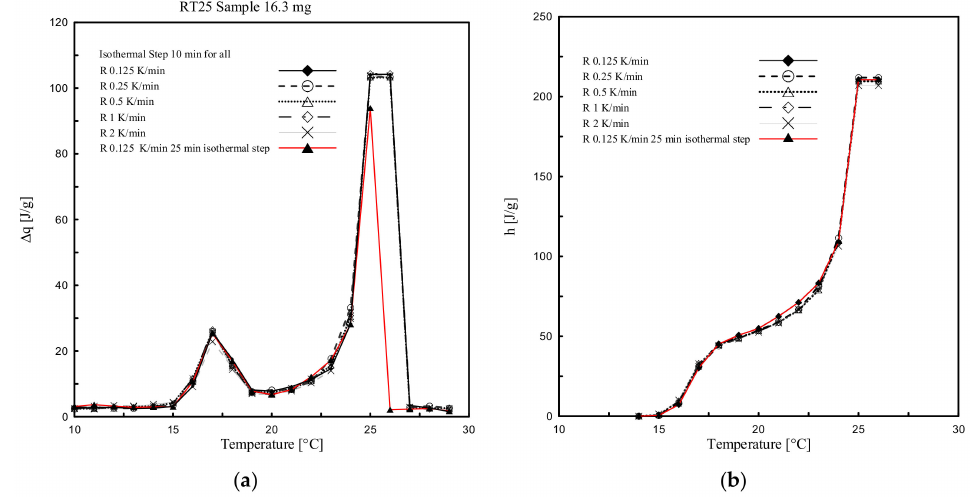
Figure 15. ( a ) ∆ q (T) and ( b ) h(T) curves determined through stepwise DSC and considering di ff erent heating rates for RT25.